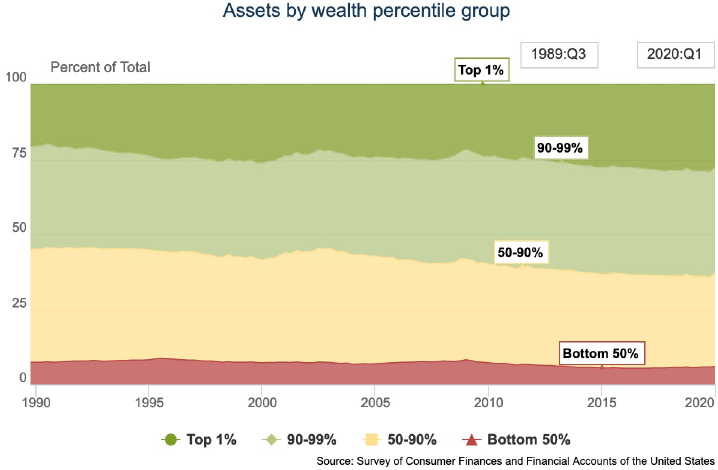
Fig 1. US wealth development. Wealth distribution for top 1%, 90–99%, 50–90% and bottom 50% of population, development 1989–2020. [30].